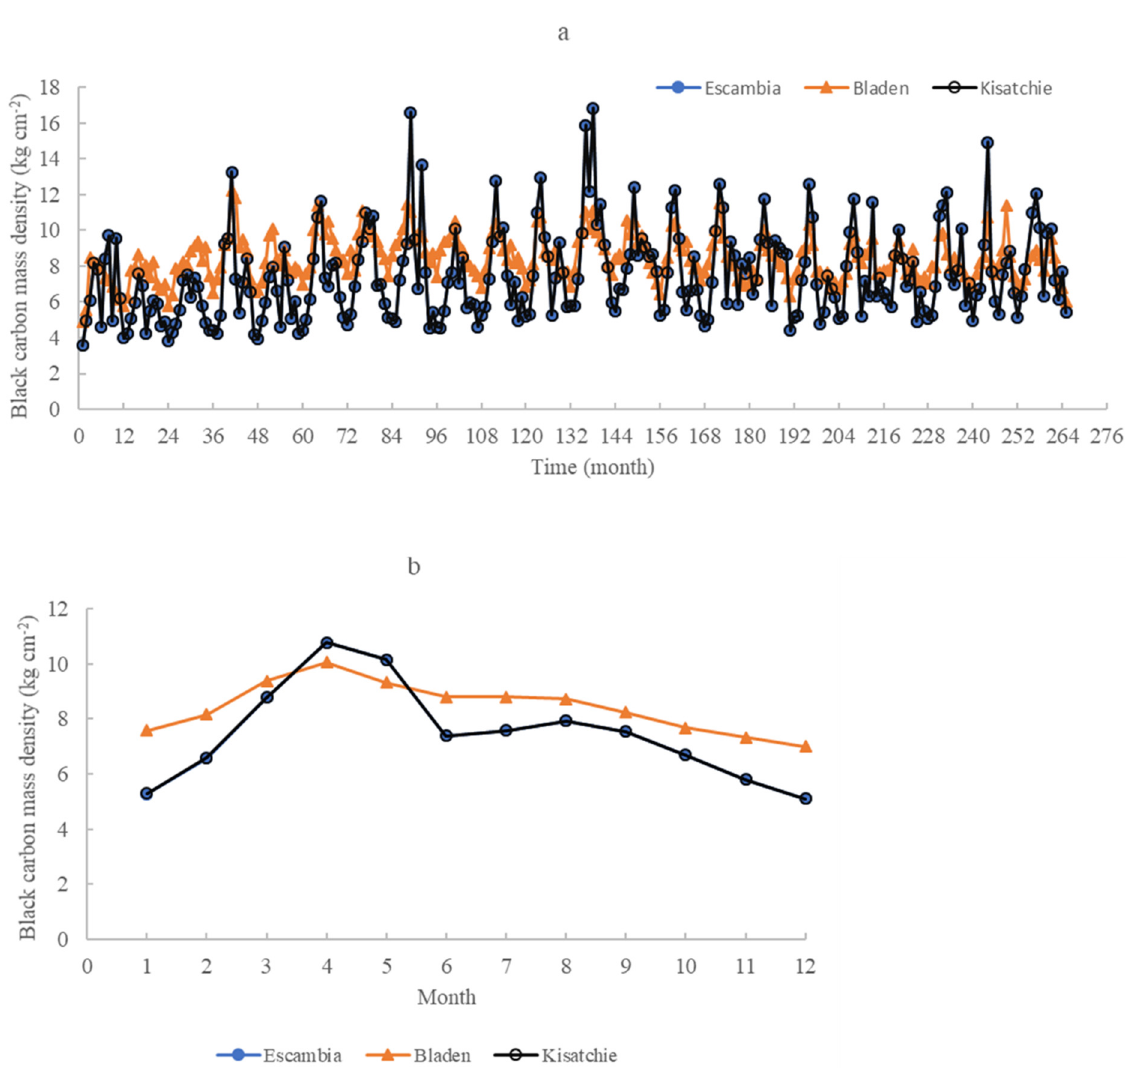
Figure 3. Dynamics of black carbon column mass density in Escambia, Bladen, and Kisatchie. ( a ) Monthly and yearly dynamics of black carbon column mass density in the three areas from January 2000. ( b ) The integrated monthly average of black carbon column mass density.